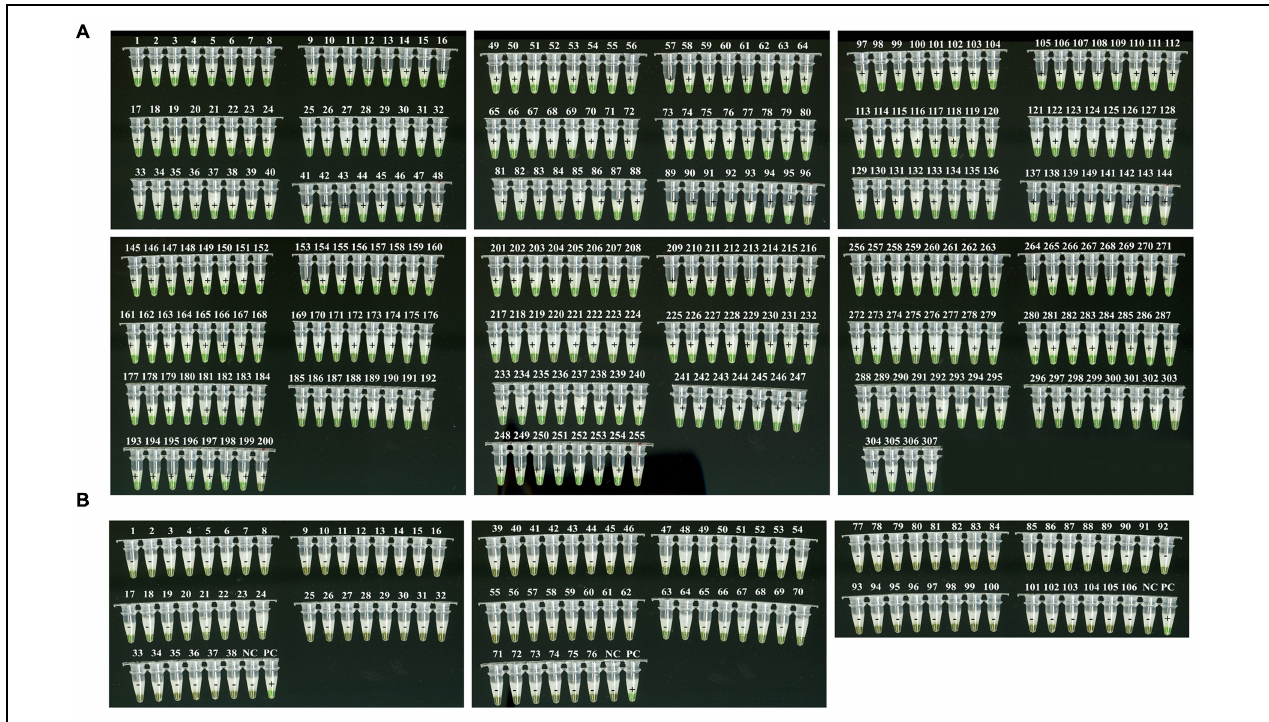
FIGURE 4 | Visual detection of RT-LAMP findings of 413 patients with clinically suspected infections in Sierra Leone. Sample information is listed in Supplemental Tables S1 and S2. A total of 307 positive (A) and 106 negative (B) samples were tested for EBOV infection by real-time RT-PCR and RT-LAMP. NC, negative control (distilled water); PC, positive control (artificial EBOV RNA).